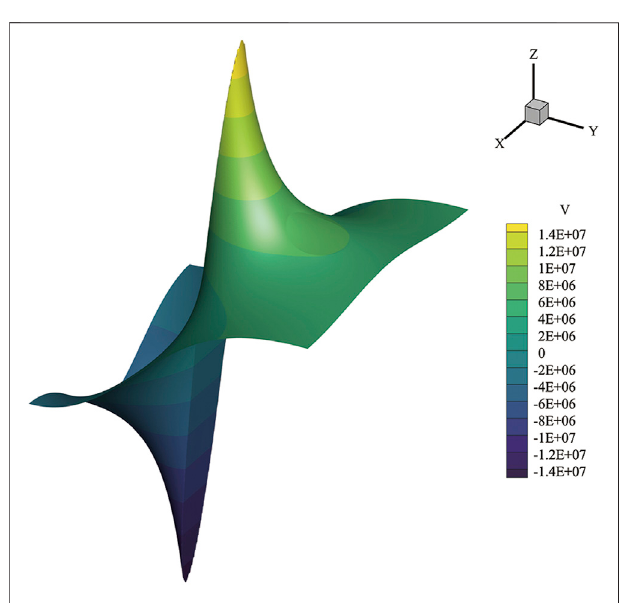
FIGURE 6 | The magnetic potential V of the permanent magnet attracting the particle model is obtained by the IIM